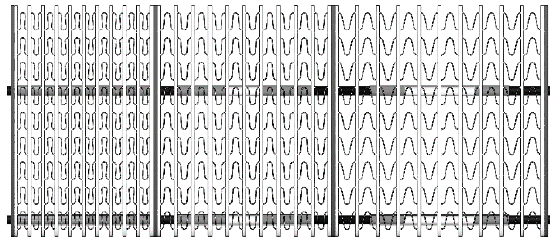
Figure 2. Three partitions: compressed, baseline and extended.